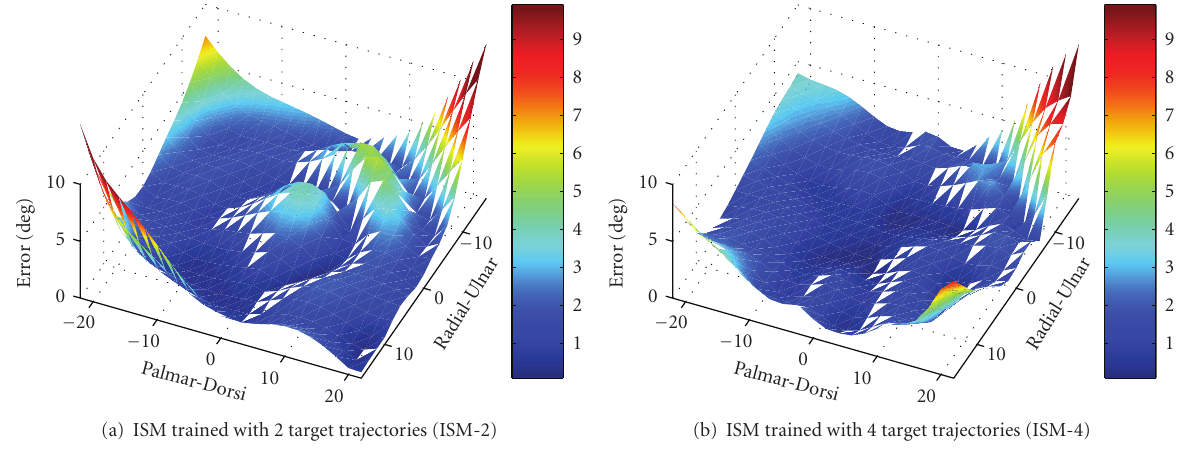
Figure 5: An example of evaluation results of ISM in positioning control (model A).